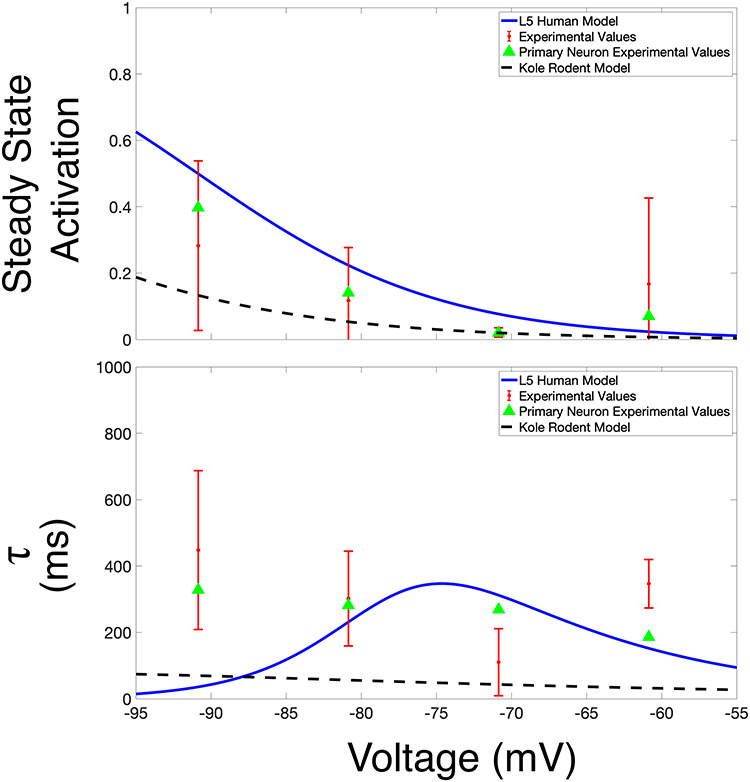
The human h-current model presented in this work is validated by comparison to experimental voltage clamp data. Plots of steady-state activation (top row) and \documentclass[12pt]{minimal}
\usepackage{amsmath}
\usepackage{wasysym}
\usepackage{amsfonts}
\usepackage{amssymb}
\usepackage{amsbsy}
\usepackage{upgreek}
\usepackage{mathrsfs}
\setlength{\oddsidemargin}{-69pt}
\begin{document}
}{}$\tau $\end{document} (bottom rows) curves over an illustrative voltage range (discussed in more detail in the text). The values for our L5 Human h-current model are shown in blue, with these values juxtaposed with those extracted from voltage clamp experiments: data from the primary cell are shown via green triangles, and data averaged over a secondary population L5 cortical pyramidal cells (with the standard deviation shown via error bars) are shown in red. For comparison, analogous curves from the Kole et al. (2006) rodent h-current model are shown via a dotted black line.